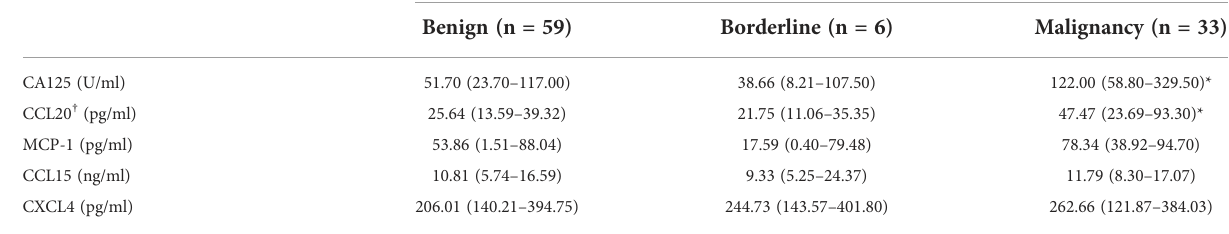
TABLE 2 Serum concentrations of potential biomarkers in the different pathological subgroups. Potential biomarker